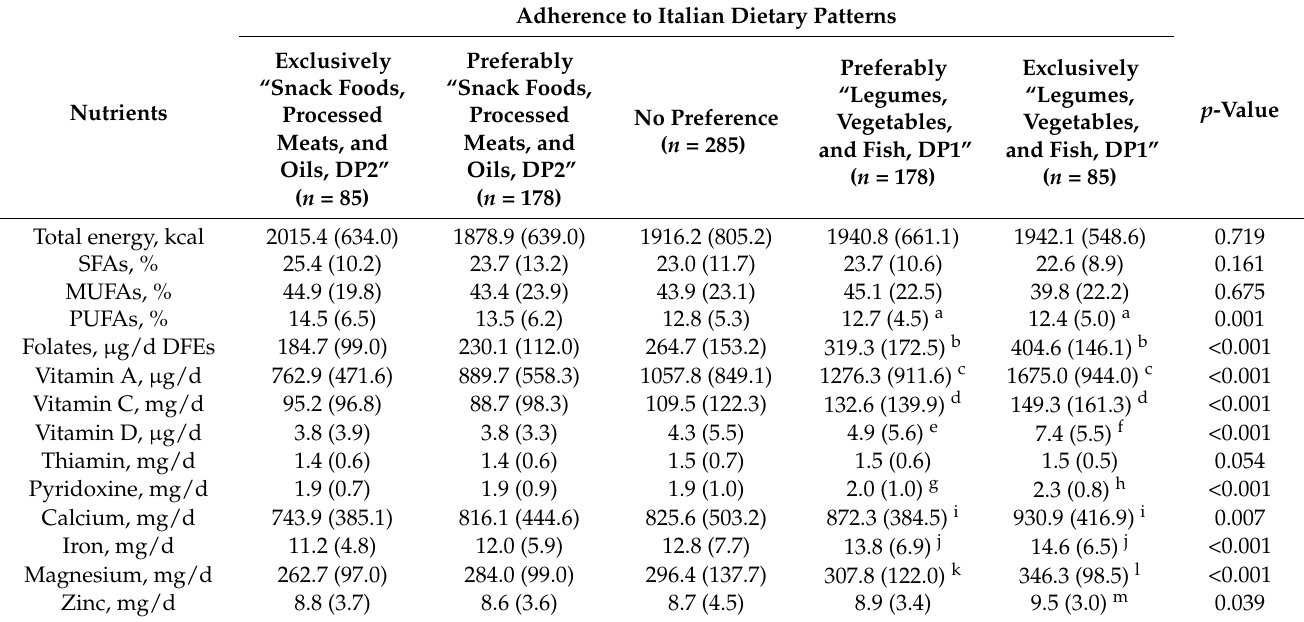
Table 5. Macro- and micronutrient intake of 811 Italian women by adherence to dietary patterns.